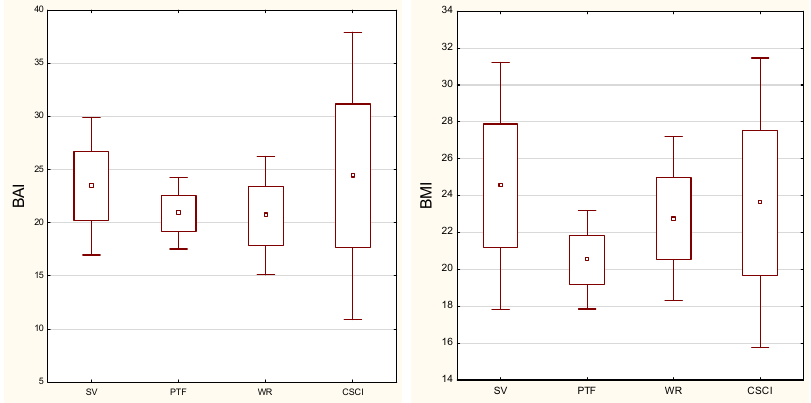
Figure 2. Distribution of body mass index (BMI) and body adiposity index (BAI) in the study groups (SV—sitting volleyball players; PTF—Para track and field athletes; WR—wheelchair rugby player; CSCI—cervical spinal cord injury). Table 3. Post hoc test for multiple comparisons of indices.